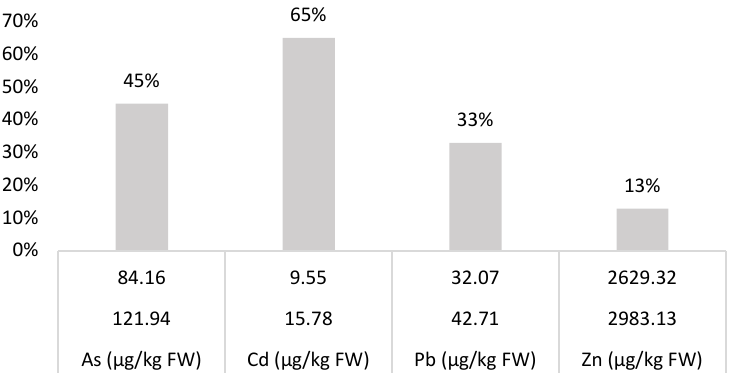
Figure 2. Differences between heavy metal concentrations in samples of fruit and vegetables washed with tap water and vinegar (10% acetic acid).